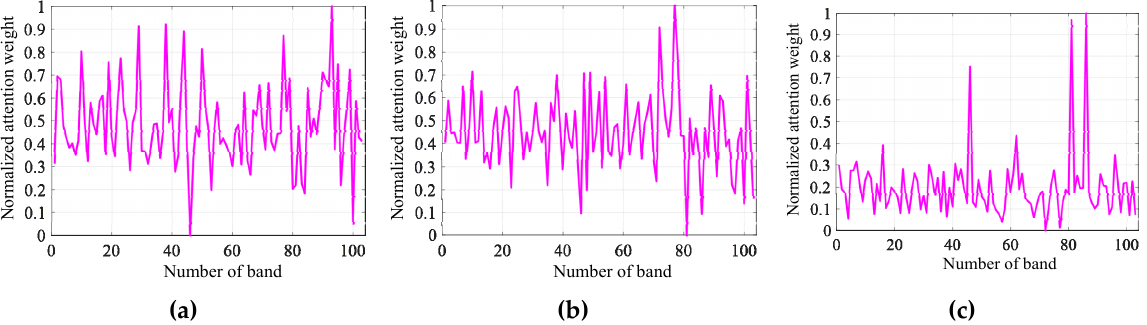
Figure 10. Visualization of attention weights for the head 2, layer 2 of T-SST on the Salinas dataset. ( a ) Dependency rela- tions between the band 1 and another band; ( b ) dependency relations between the band 100 and another band; ( c ) de- pendency relations between the band 204 and another band.